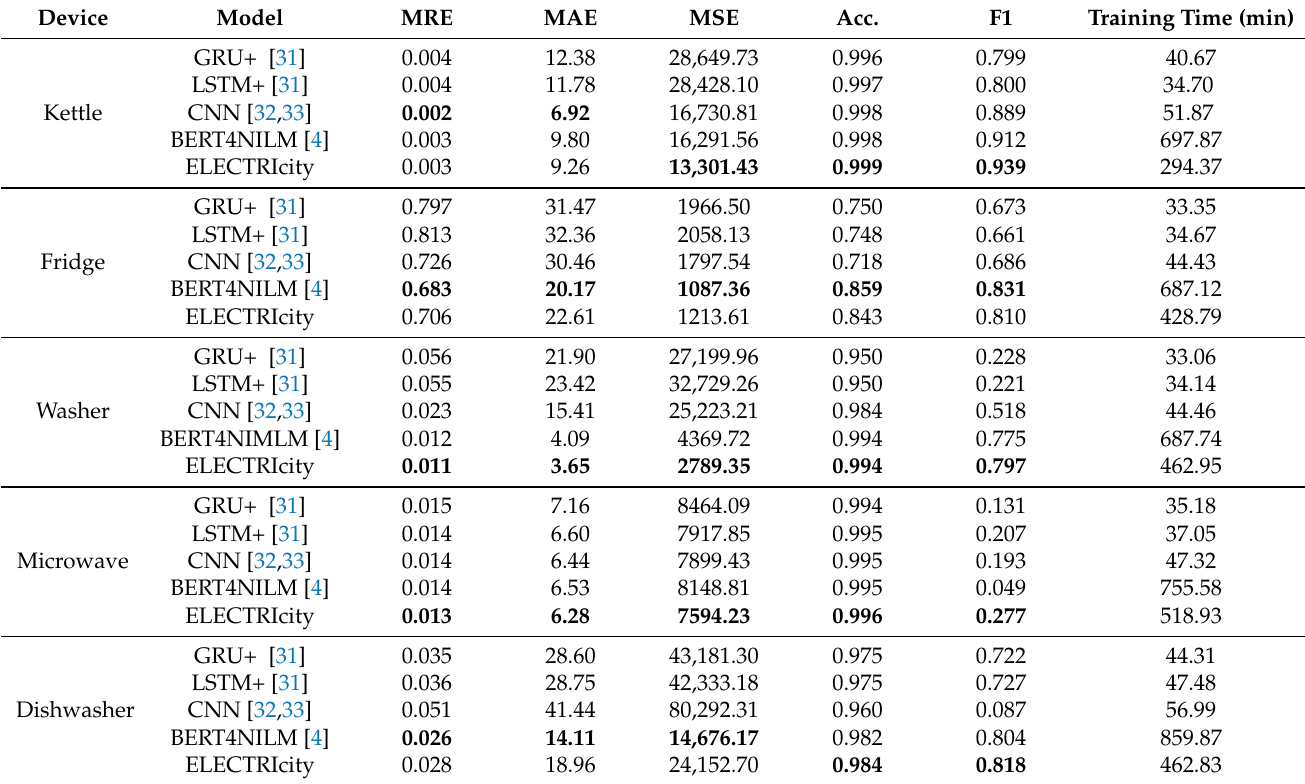
Table 2. Comparison of ELECTRIcity’s model performance to other techniques in the UK- DALE